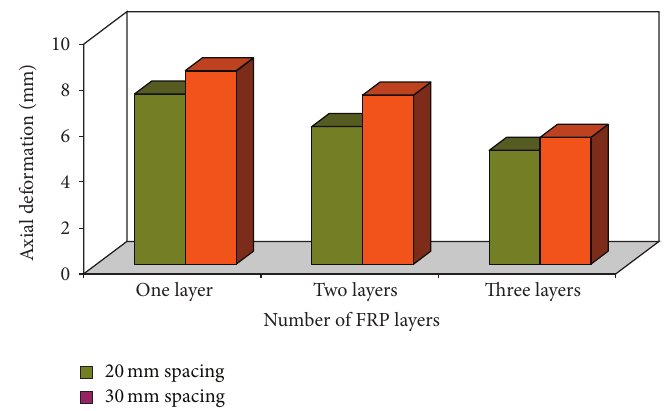
Figure 17: Axial deformation for all columns—comparison.